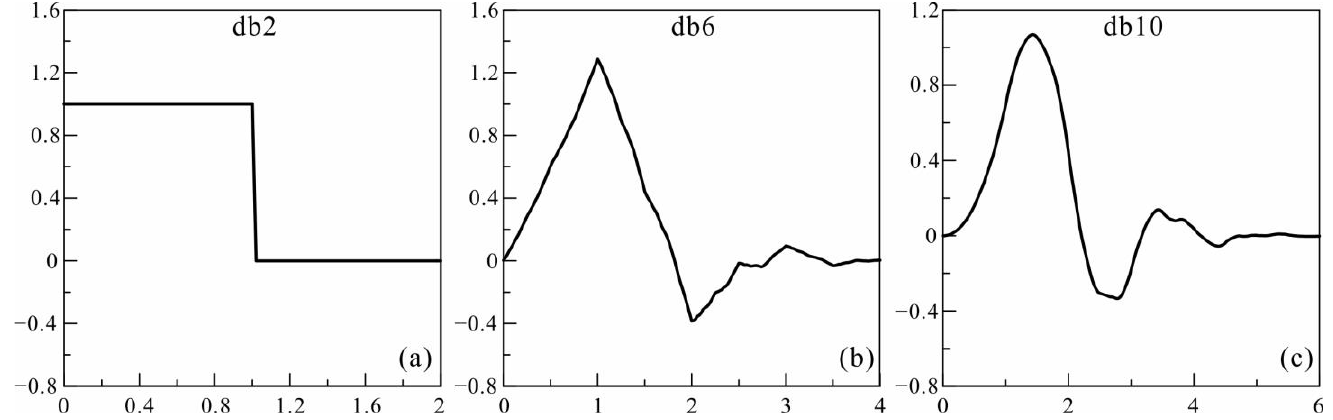
Figure 1. Scaling functions of the wavelet with varying orders (db2, db6 and db10). ( a ) db2, ( b ) db6, ( c )